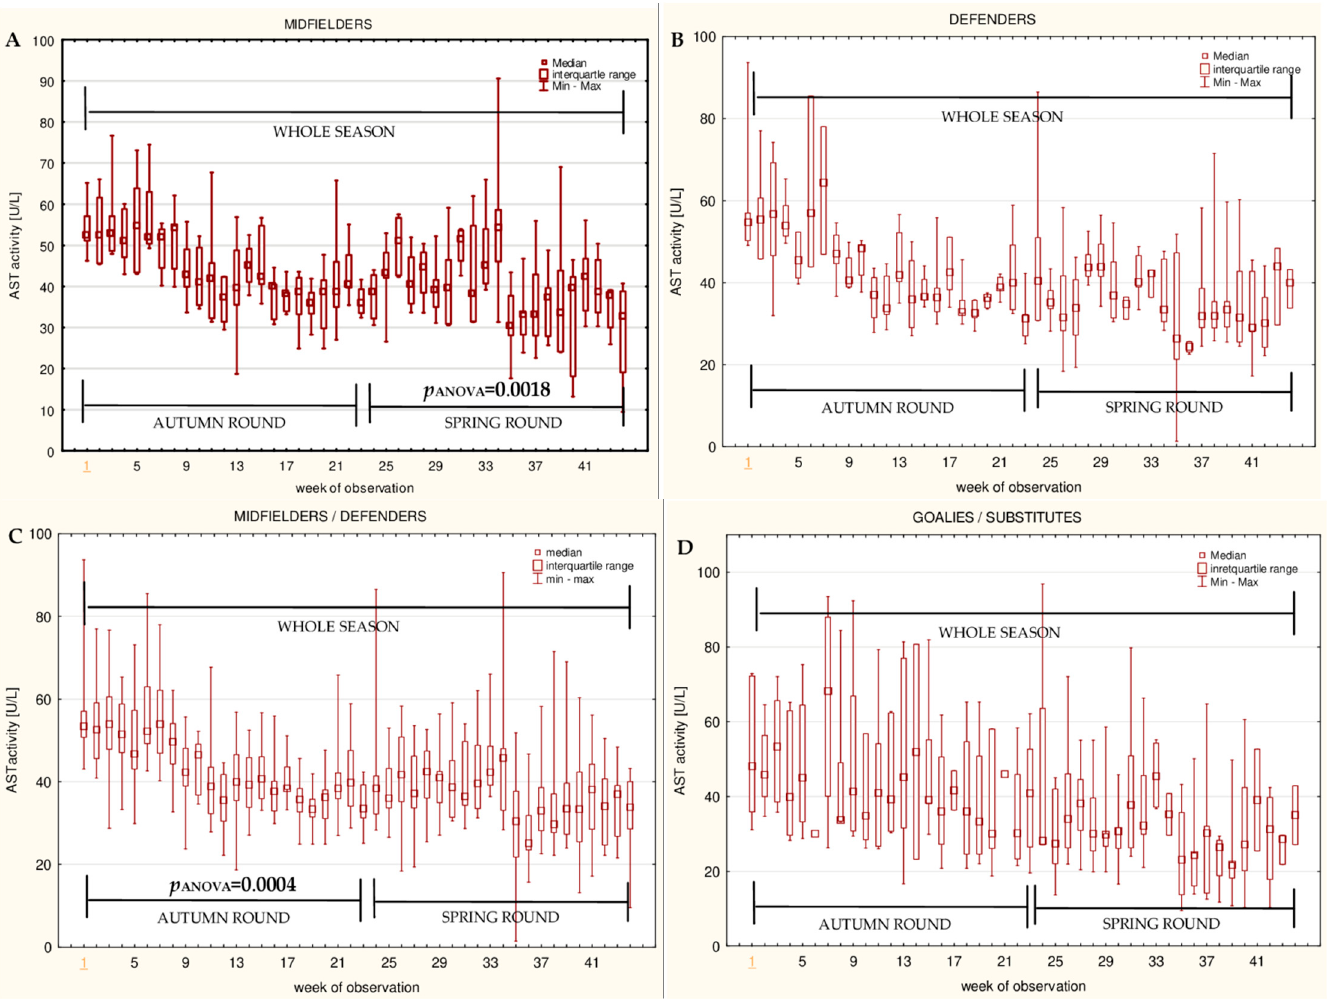
Figure 1. Median aspartate aminotransferase activities (AST) in: ( A ) The midfielder, ( B ) defender, ( C ) midfielder / defender and ( D ) goalie / substitute subgroups over the course of the soccer match season.